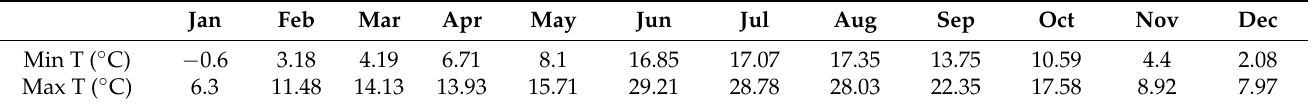
Table 1. Climate characterization [i.e., average, minimum, and maximum temperature (°C) and rain (mm)] of Tenna